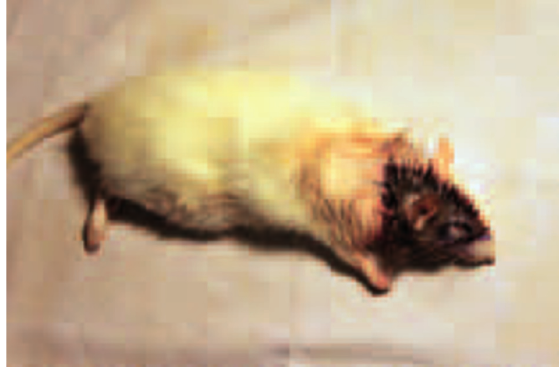
Figure 9. Postop view of a recipient rat